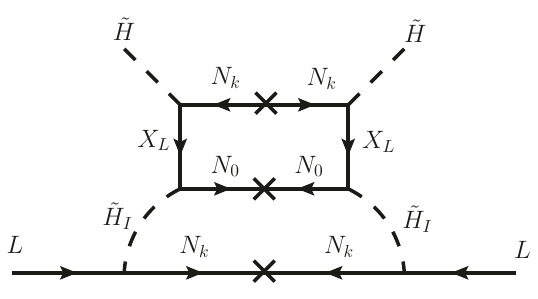
Figure 2 . Two-loop diagram for the Majorana neutrino